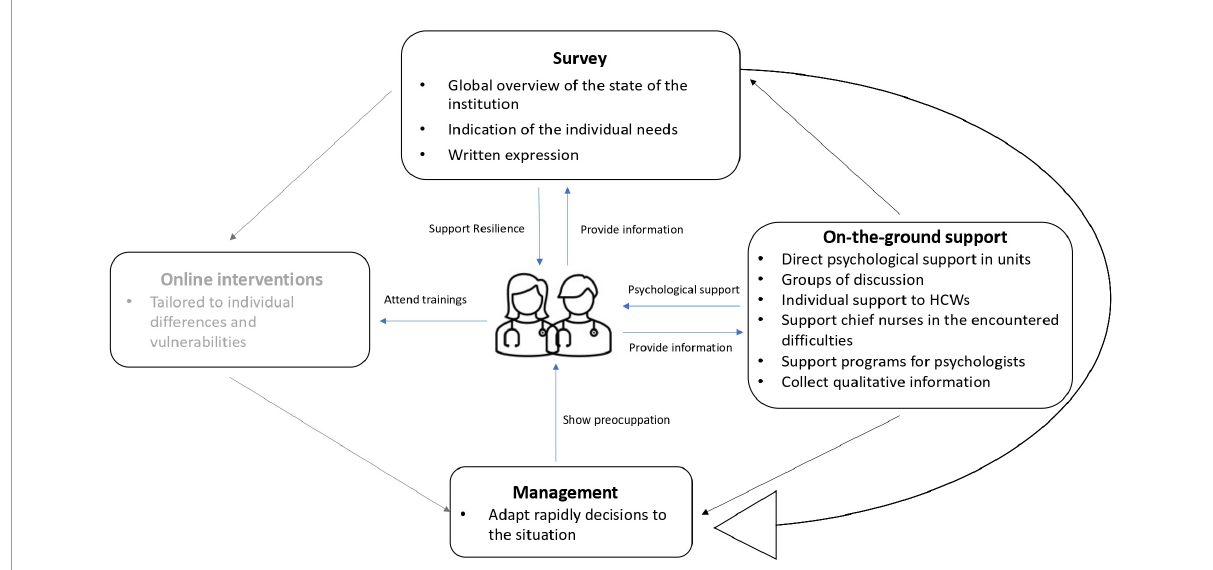
FIGURE1 The general proposition of a model to support the resilience of healthcare workers (HCWs) when faced with a crisis. The blue lines indicate the interactions between the different approaches and the healthcare workers. The black lines indicate how the four interveners communicate with one another to tailor the general strategy. The gray part (online interventions) concerns a new project to be implemented in the